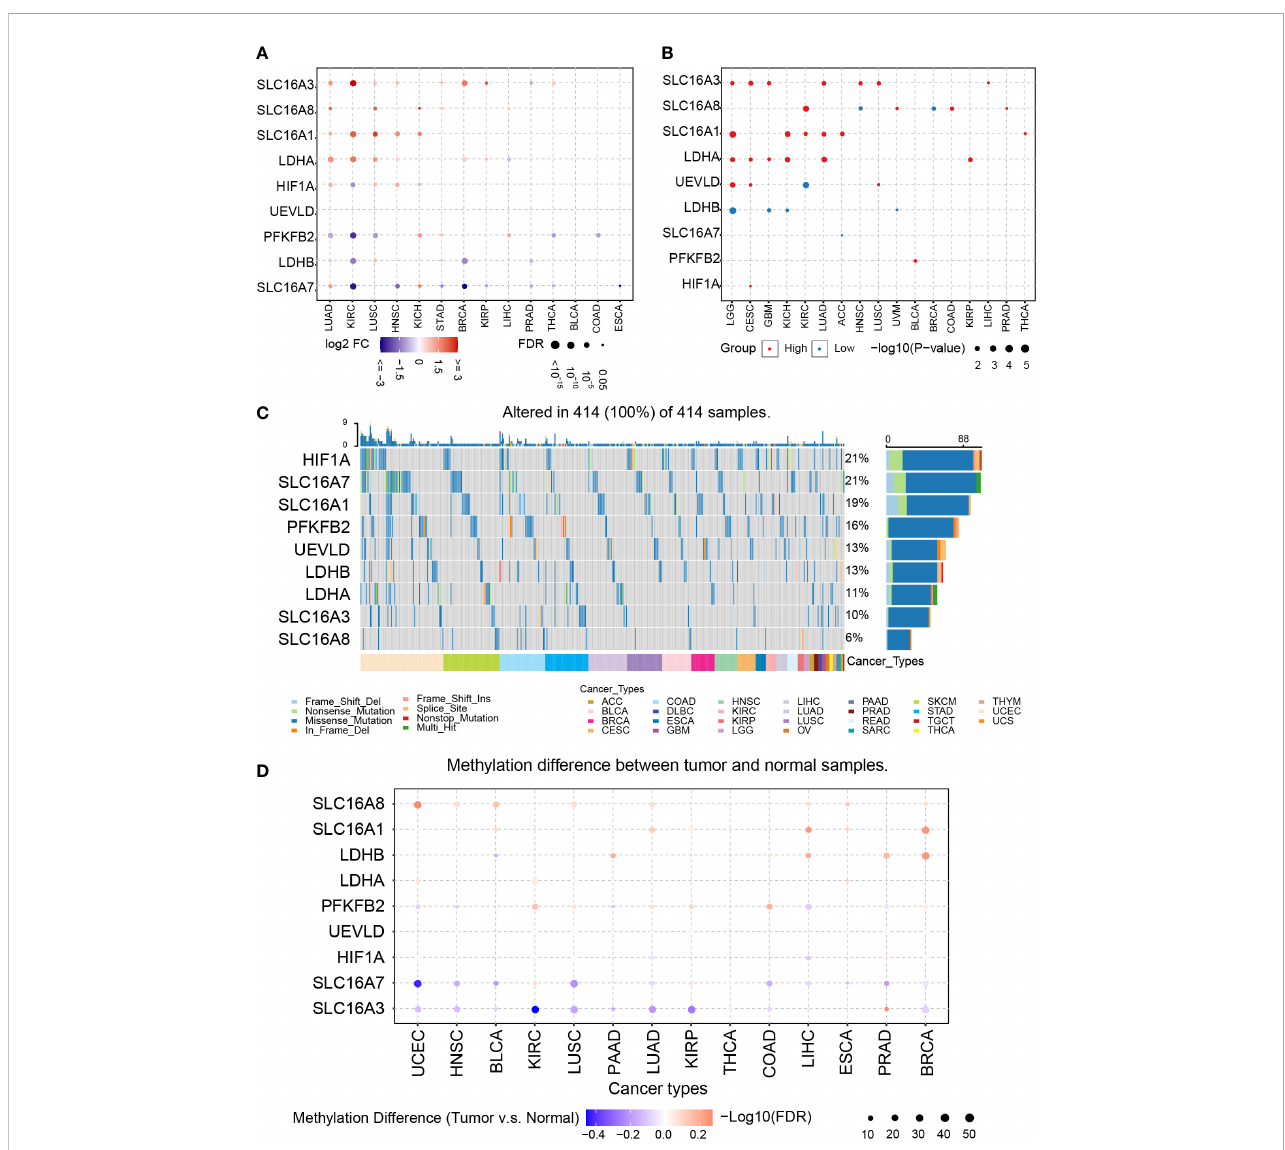
FIGURE 1 Pan-cancer analysis of LAGs. (A) The expression of LAGs in various tumors. (B) The survival analysis of LAGs in various tumors. (C) The SNPs of LAGs in various tumors. (D) The methylation status of LAGs in various